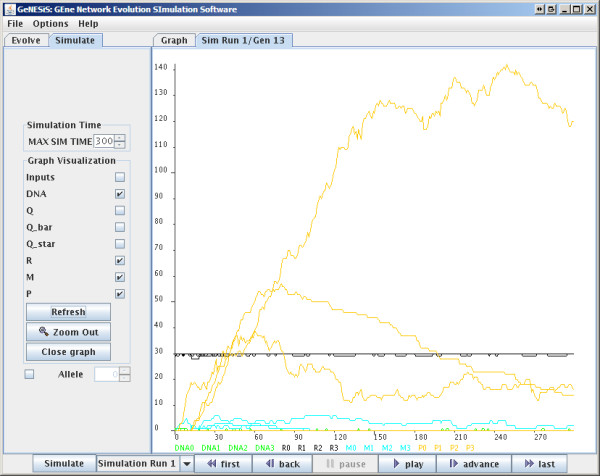
Simulation Window.